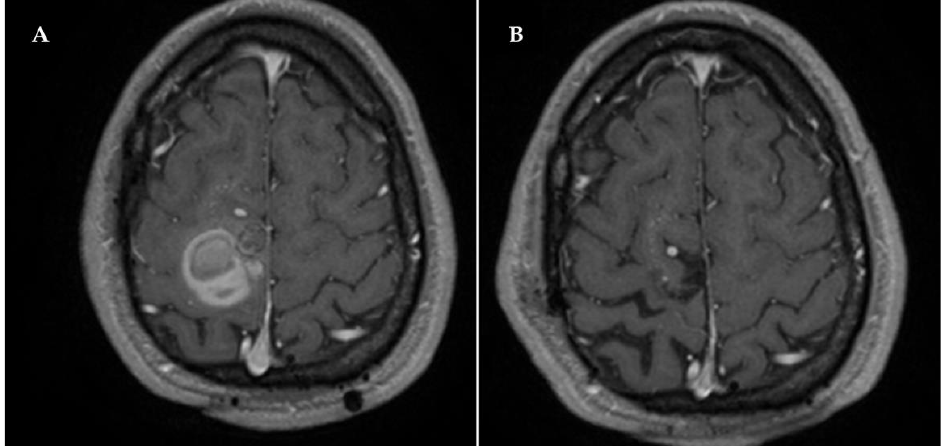
Figure 2. ( A ) Axial MRI view of the patient ’ s brain, showing the presence of a newly formed hem- orrhagic CCM lesion close to the pre-existing DVA. ( B ) Postoperative axial MRI demonstrating com- plete removal of the newly formed CCM